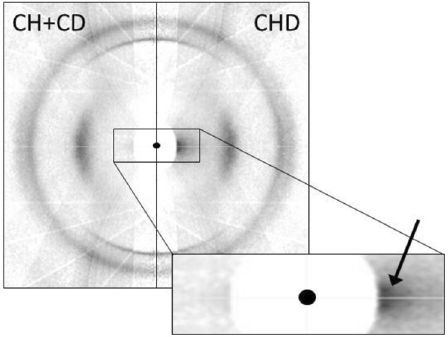
Fig.4|FiberdiffractionpatternscollectedfromcelluloseIIusingneutrons. The lefthalfoftheimage(CH+CD)istheaverageofdatacollectedfromCH-celluloseII and CD-cellulose II. The right half of the image (CDH) is data collected from CDH- celluloseII.Theblackcircleinthecenteroftheimagerepresentsthepositionofthe directbeamofneutronsafterpassingthroughthesample.Thevertical,meridional, directioncorrespondstothedirectionofthe fi beraxisandthecellulosechains.The equatorofthediffractionpatternpasseshorizontallythroughthebeamcenterand correspondstothepackingdirectionofneighboringcellulosechains.Thetwosides of the composite image are identical, with the exception of some low-angle intensity on the equator of CDH-cellulose II, indicated by an arrow in the enlarged